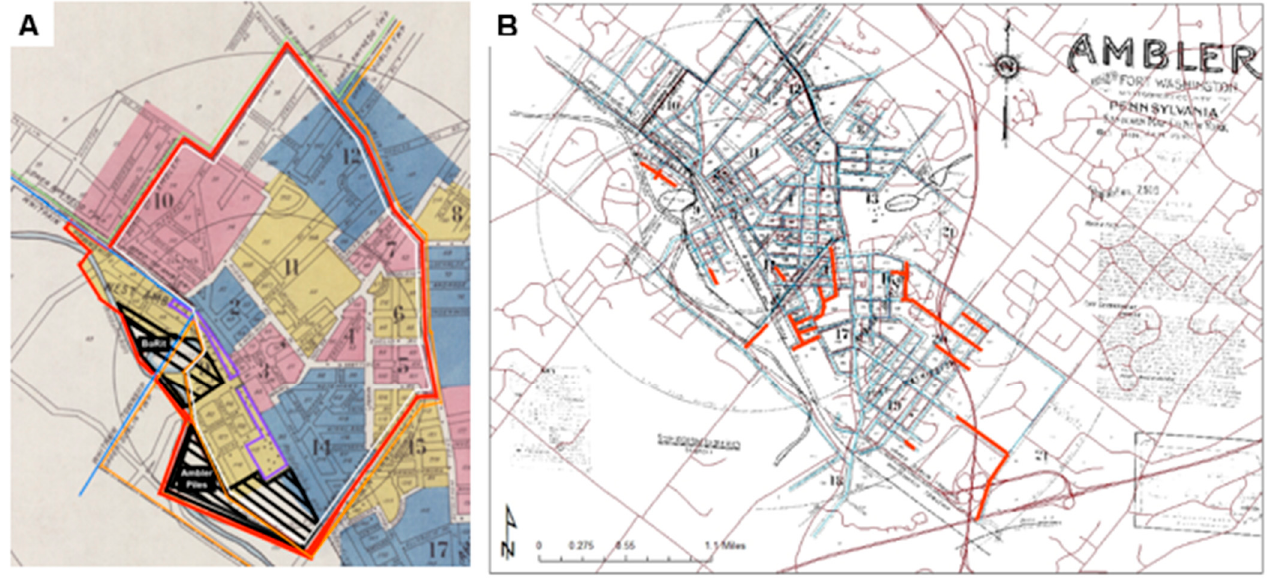
Figure 1. Historic Maps of Ambler, PA ( A ) 1930 Sanborn Fire Insurance Map including Riskscape, asbestos manufacturing, and waste sites superimposed on Sanborn Fire Insurance Map; This map depicts the riskscape enclosed in red, Ambler Borough (white lines), Whitpain Township (blue lines), Upper Dublin (light orange), and Lower Gwynedd (green). The asbestos manufacturing buildings (purple) and waste site areas (black) are also shown. ( B ) Streets that no longer exist in 2016 (indicated in Red), on 1930 Sanborn Fire Insurance map and surrounds.